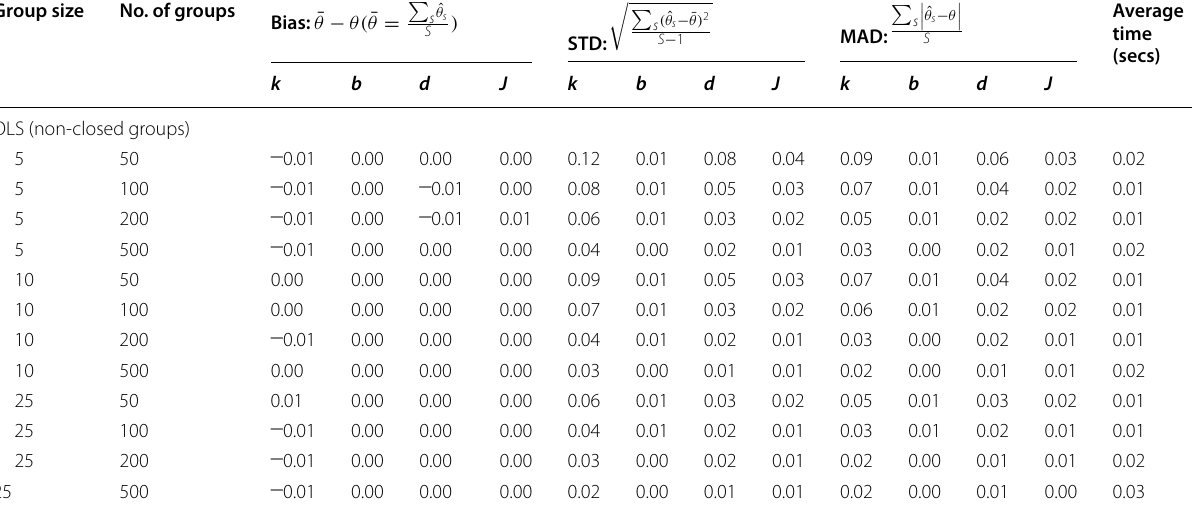
Table 7 Bias, standard deviation and mean absolute deviation of the estimates for the linear (OLS) model with non-closed groups Group size